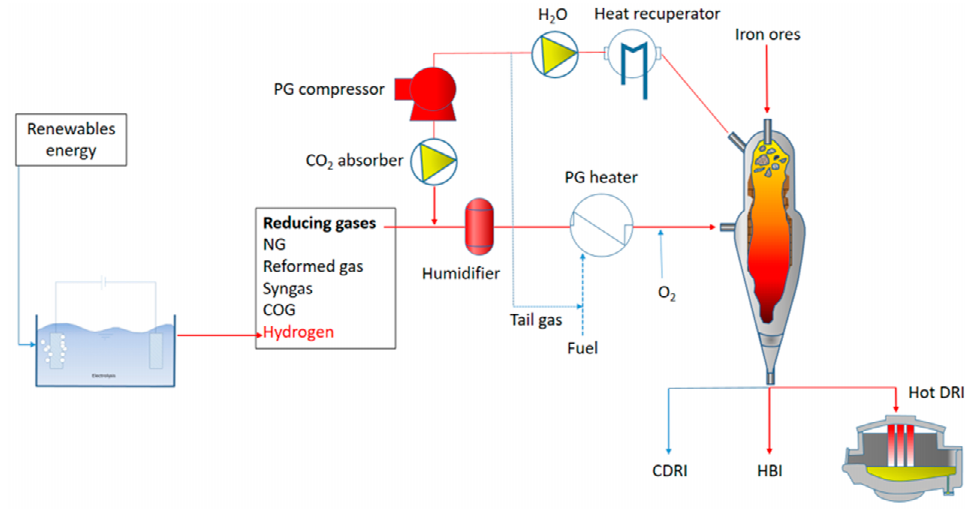
Figure 15. Schematic of HYL-DRI plant.